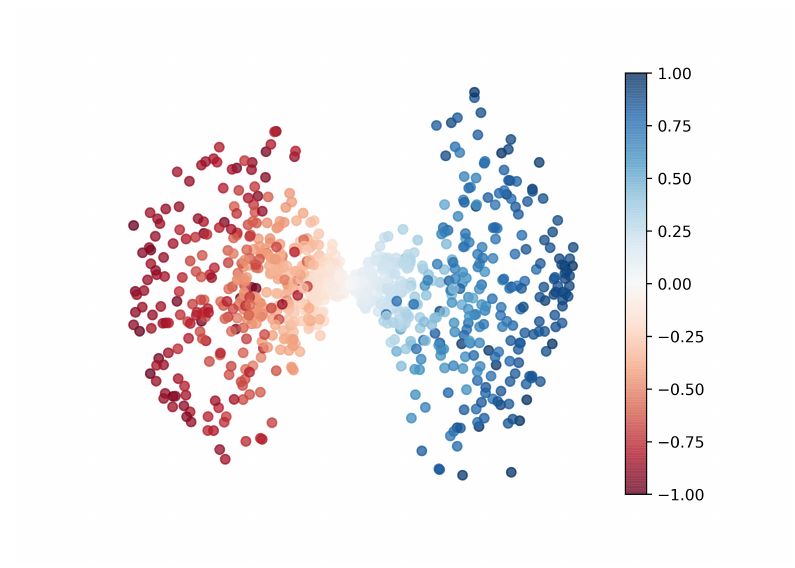
Figure 8. Bidimensional reduction of the points R ( w ) , using PCA. The color denotes the score s ( w ) .